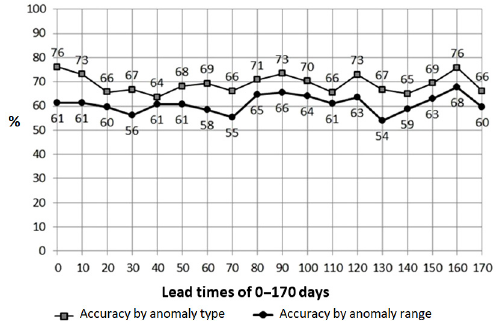
Figure 6. The same as Figure 3 for seasonal (three-month mean) precipitation amount spatial anomaly